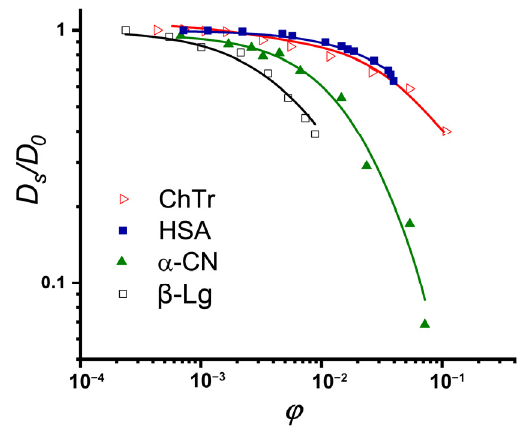
Figure 4. Normalized concentration dependencies of self- diffusion coefficients of ChTr (pH = 3.5, I = 0.01 M), HSA (pH = 7.2, I = 0.01 M), α -CN (pH = 7.0, I = 0.01 M), and β -Lg (pH = 7.0, I = 0.003 M) The original data were obtained from [51,73,120].